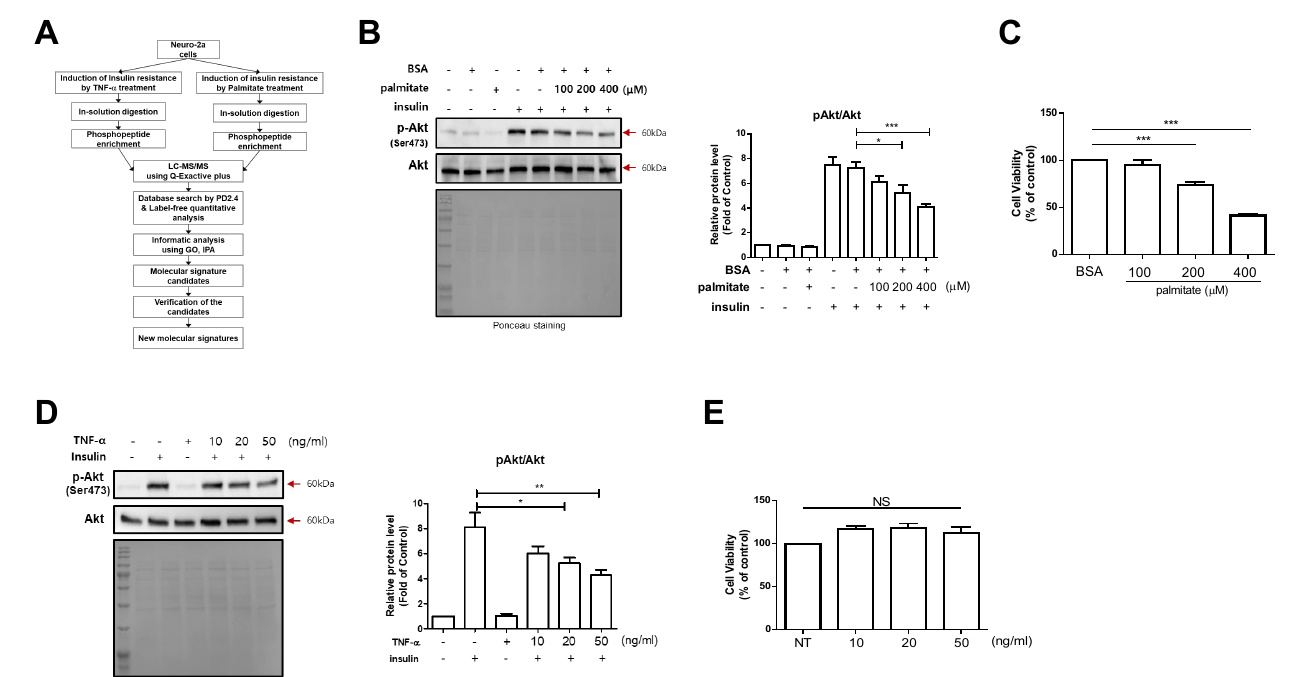
Figure 1. Induction of two different insulin-resistant conditions on Neuro-2a (N2a) cells. ( A ) Ex- perimental workflow. PD 2.4 indicates Proteome Discoverer 2.4, GO indicate gene ontology, and IPA indicates Ingenuity pathway analysis, respectively. ( B ) Western blot of phosphorylated protein kinase B (Akt) that mediated insulin downstream signals under palmitate-induced insulin